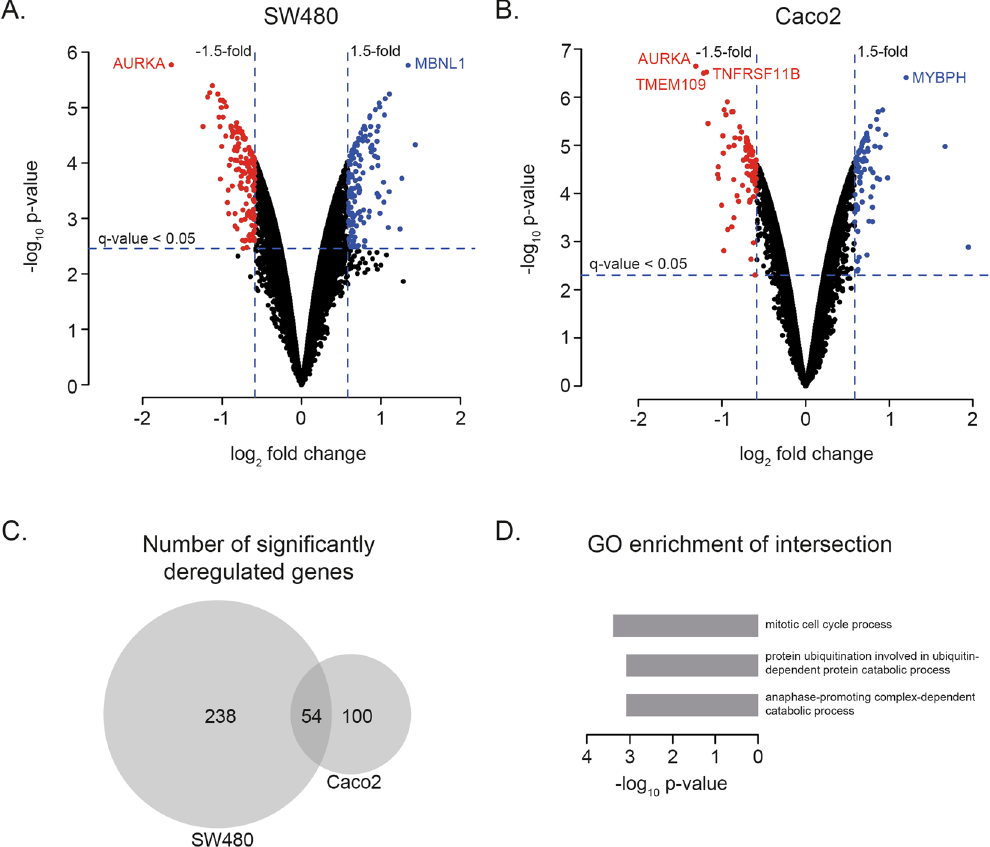
Figure 1. Differential mRNA expression analysis of AURKA knockdown in SW480 ( A ) and Caco2 ( B ) colorectal cancer cell lines. ( A ) and ( B ) Volcano plot of all unique genes from the differential mRNA expression analysis upon AURKA downmodulation for the SW480 and Caco2 cell lines, respectively. The vertical and horizontal lines illustrate the boundaries between significantly downregulated genes (red dots), significantly upregulated genes (blue dots) and non-significant differential genes (black dots). Horizontal lines represent the significance threshold of the q-value < 0.05. Vertical lines represent the significance threshold of the fold change 1.5 (log 2 fold change 0.58) up or down. C) VENN diagram of the number of significantly deregulated genes in SW480 and Caco2 (see Table 1). D) GO enrichment of the genes (n = 53) that are significantly deregulated in both cell lines in the same direction (the intersection in the Venn diagram in C minus one